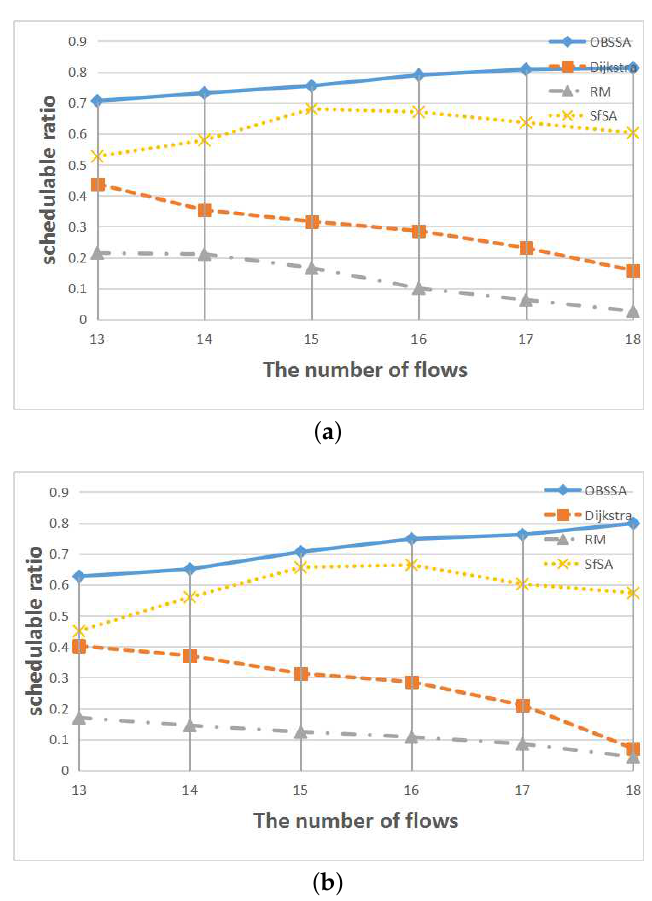
Figure 10. The relationship between the schedulability ratio and the number of flows. ( a ) N = 50, U = 0.4; ( b ) N = 50, U = 0.5.